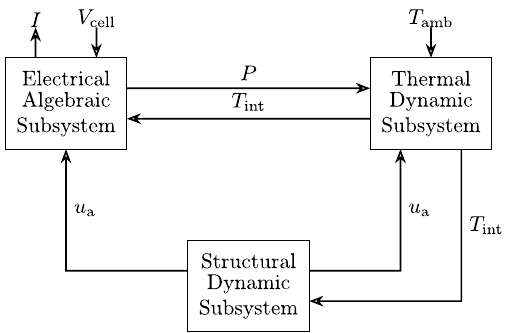
Figure 2. PCM dynamics. Block diagram illustration of the interplay between the electrical, thermal and structural dynamics in a PCM device. The system has two inputs V cell and T amb and one output I . V cell is the voltage drop on the PCM device. T amb denotes the ambient temperature at which the device is operated. I is the current flowing through the device. P is the electrical power dissipated by the device and is computed as the product between I and V cell . u a is the effective thickness of the amorphous region and its evolution is determined by the crystallization dynamics. T int is the temperature at the amorphous-crystalline interface and its evolution is determined by the heat balance equation.